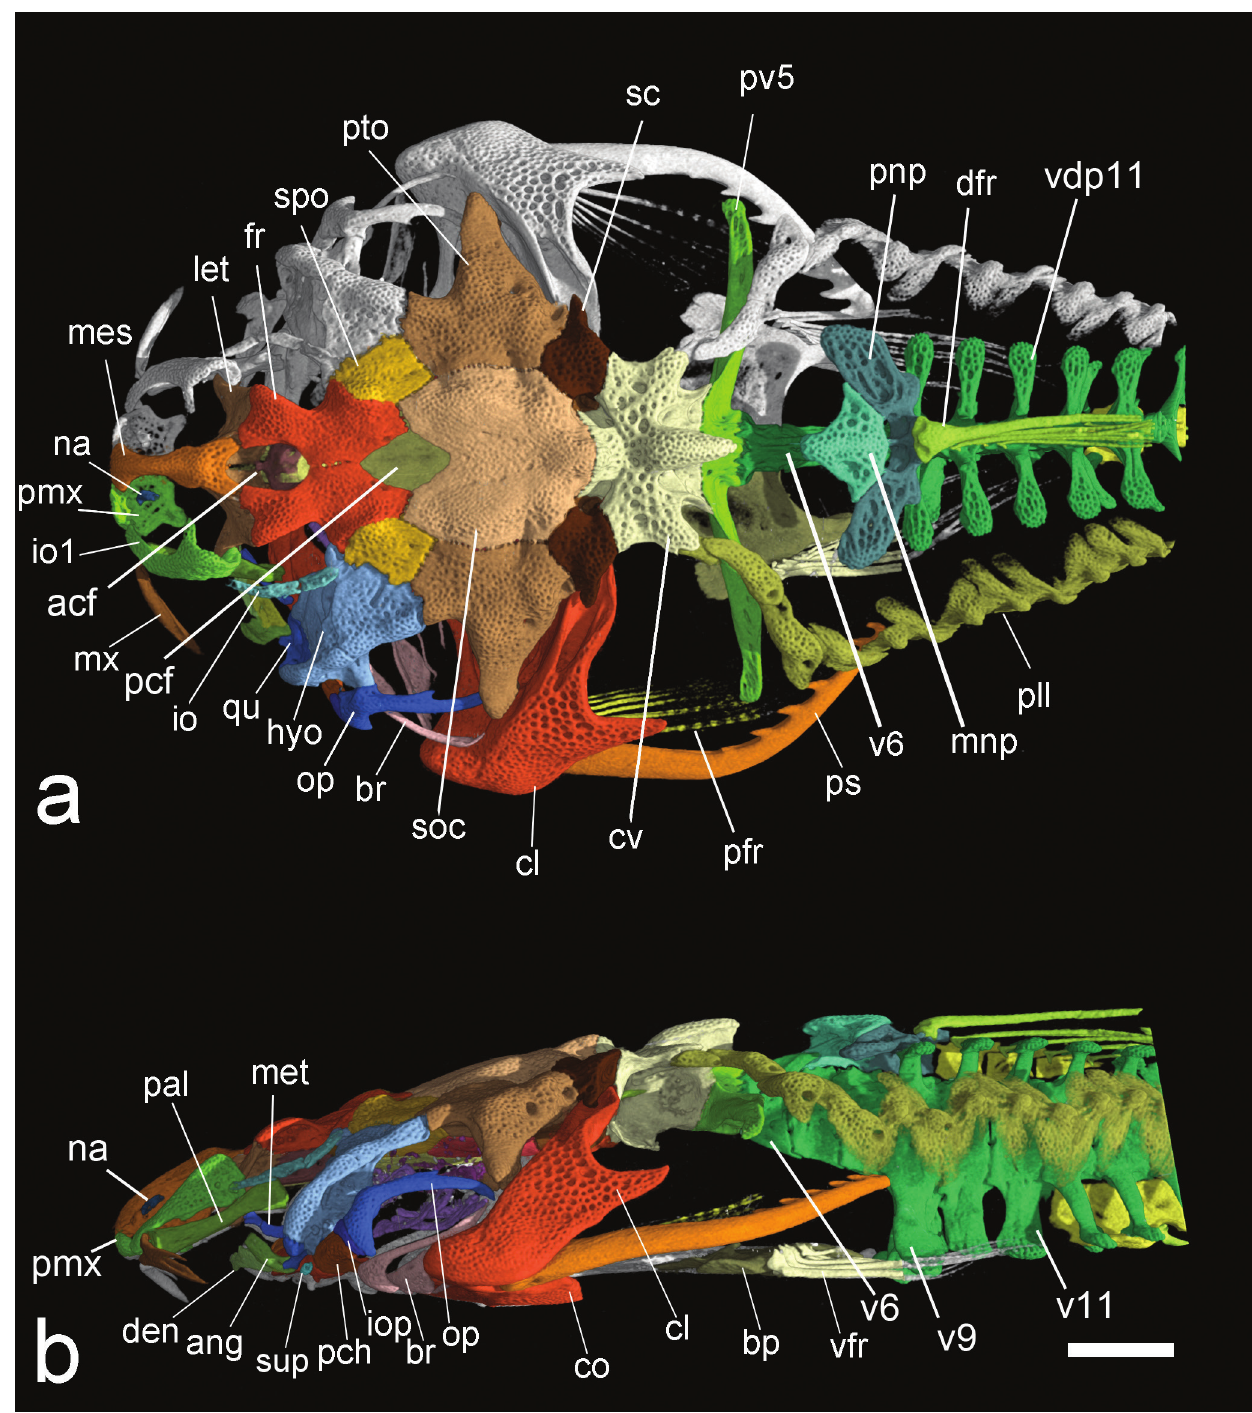
Fig. 3. HRXCT model of skull and anterior body of Hoplomyzon cardosoi , MCNG 375, holotype, 18.5 mm SL. a. Dorsal view. b. Lateral view of left side. acf: anterior cranial fontanel; ang: anguloarticular; bp: basipterygium; br: branchiostegal rays; cl: cleithrum; cv: complex vertebrae; den: dentary; dfr: dorsal-fin rays; fr: frontal; hyo: hyomandibula; iop: interopercle; let: lateral ethmoid; mes: mesethmoid; met: metapterygoid; mnp: middle nuchal plate; mx: maxilla; na: nasal; pal: autopalatine; pcf: posterior cranial fontanel; pch: posterior ceratohyal; pfr: pectoral fin rays; pll: posterior lateral line plates; pmx: premaxilla; ps: pectoral-fin spine; pto: pterotic; qu: quadrate; sc: postemporo-supracleithrum; soc: parietal- supraoccipital; spo: sphenotic; io1: infraorbitals; iop: interopercle; infraorbital 1; sup: subpreopercle; pv5: parapophysis of vertebra 5; v6: vertebra 6; v9: vertebra 9; v11: vertebra 11; vdp11: vertebral dorsal process of vertebra 11; vfr: pelvic-fin rays. Scale bar = 1